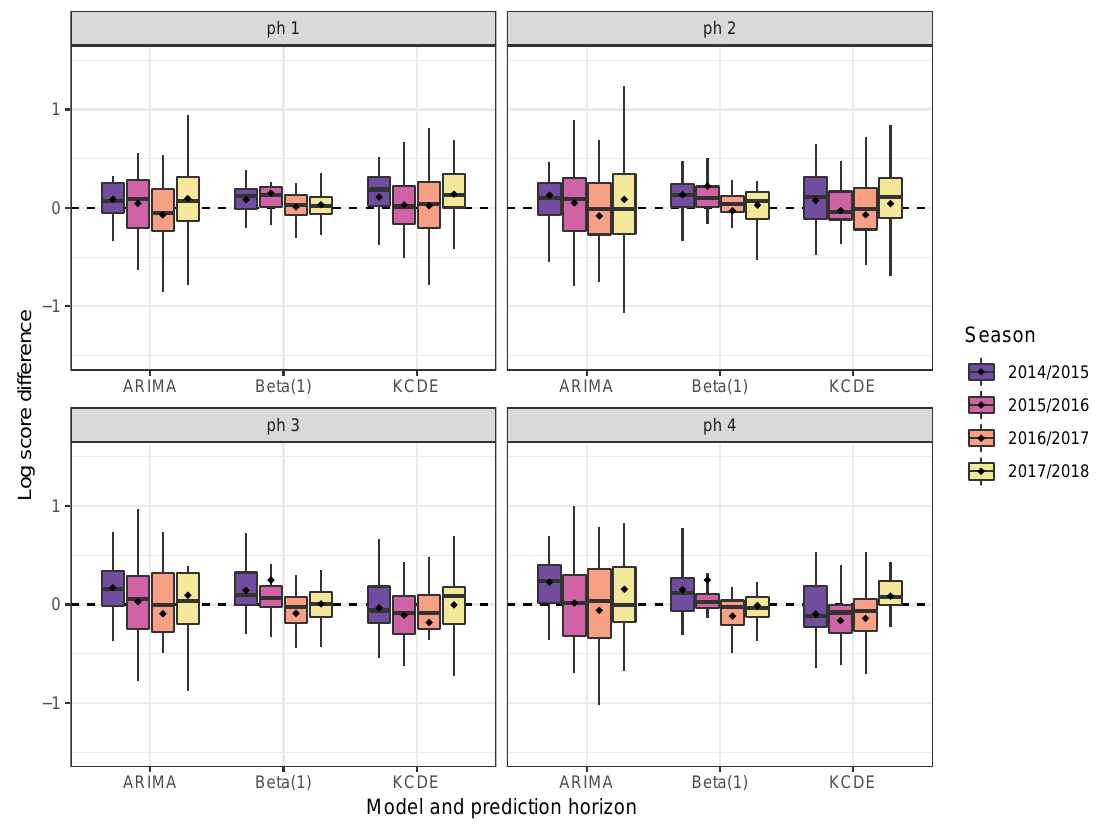
Figure 3. Boxplots of the weekly log-score differences of Beta(4) vs. Beta(1), KCDE and ARIMA, respectively, for prediction horizons of one to four weeks in the “weeks 40–20” subset of the test period, stratified by season. Positive values indicate superiority of Beta(4). The mean is marked with